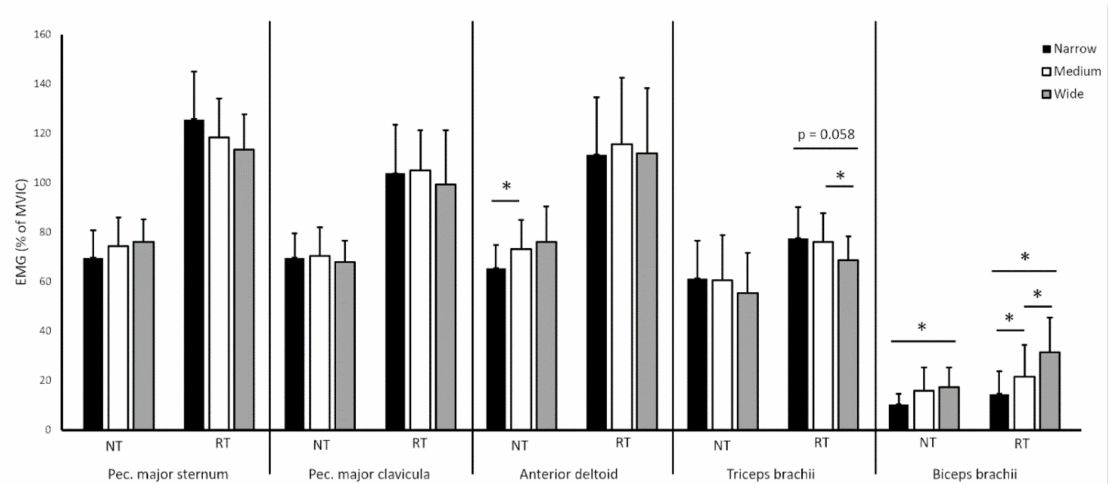
Figure 2. The normalized EMG activity (i.e., % of MVIC) for the RT group and NT group as mean (95% CI). * Significant difference between the grip